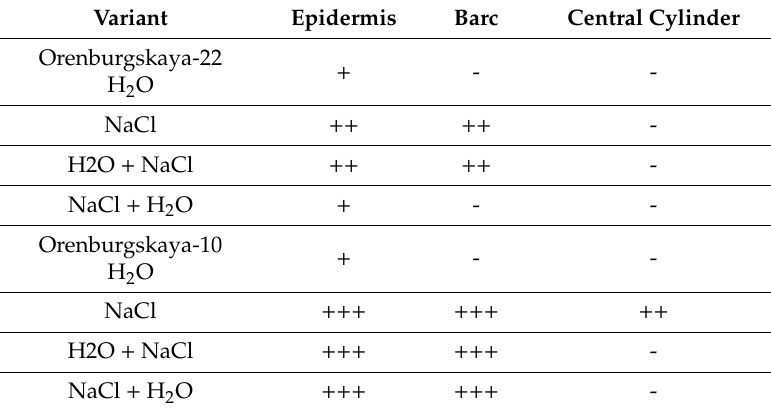
Table 2. Distribution of cells on wheat root tissues stained with ROS.